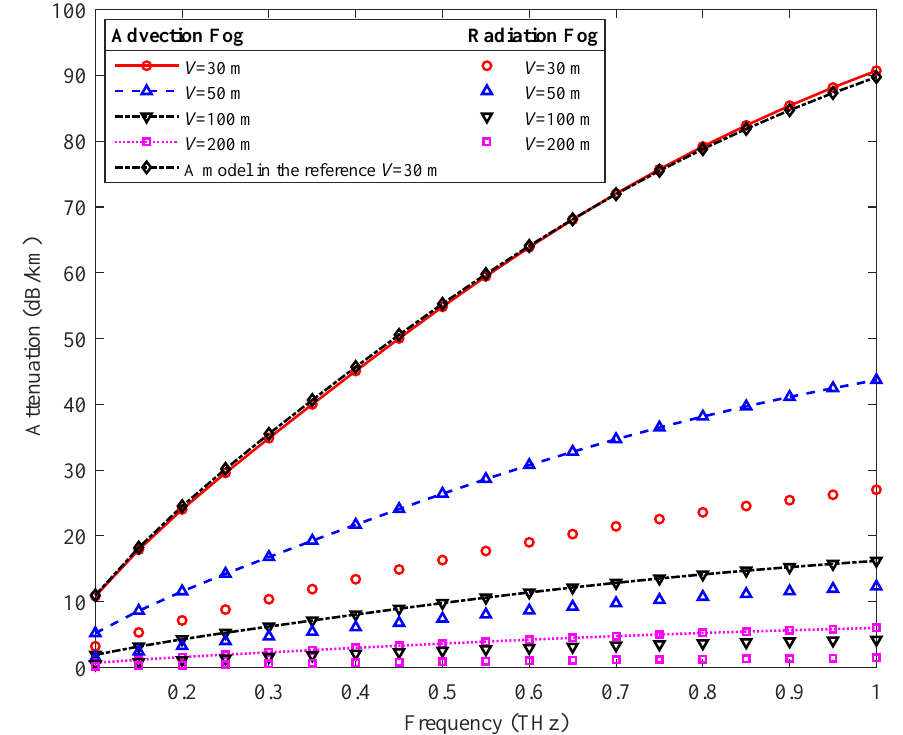
Figure 4. Fog attenuation of THz waves under diverse visibility and comparison with